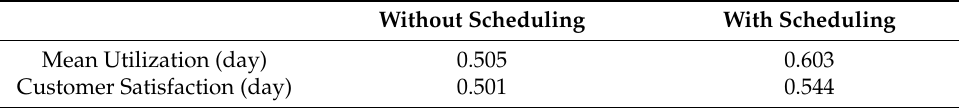
Table 7. The MU and CS on working days.